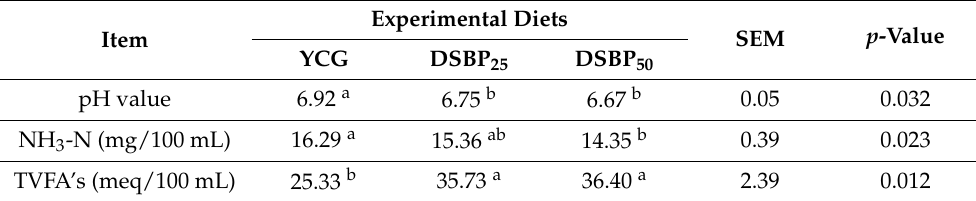
Table 6. Rumen fermentation parameters of cows fed experimental